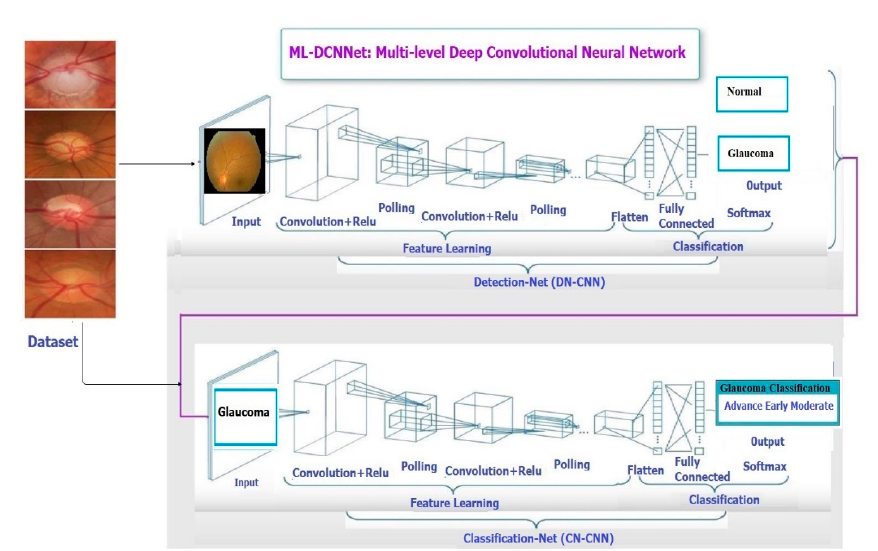
Figure 1. The Architecture of Multi-Level deep Convolutional Neural Network (ML-DCNN).